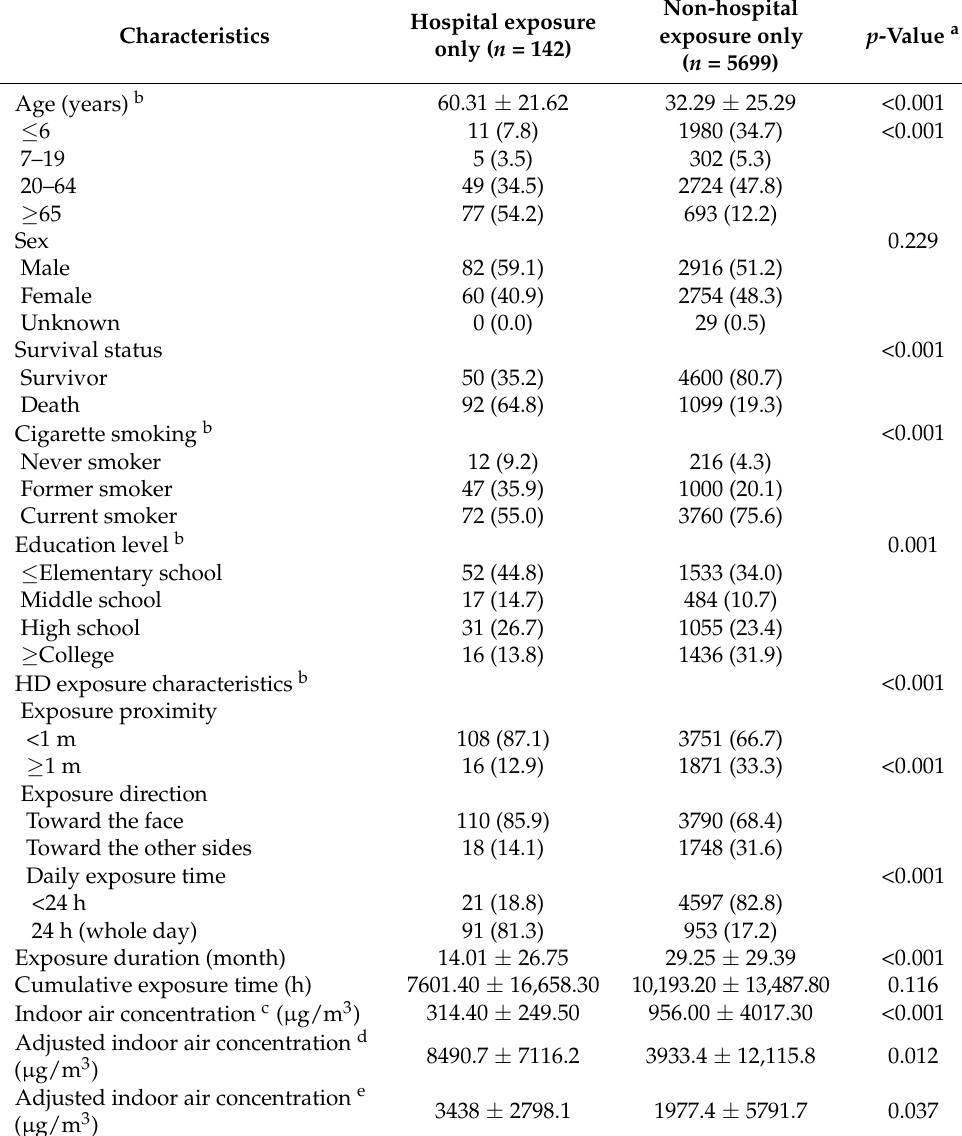
Table 3. Characteristics of participants by exposure